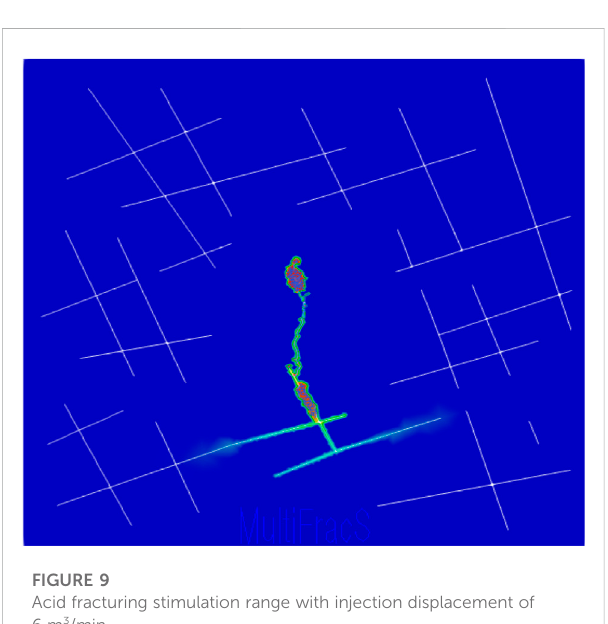
FIGURE 11 Acid fracturing stimulation range with temporary plugging pressure 15